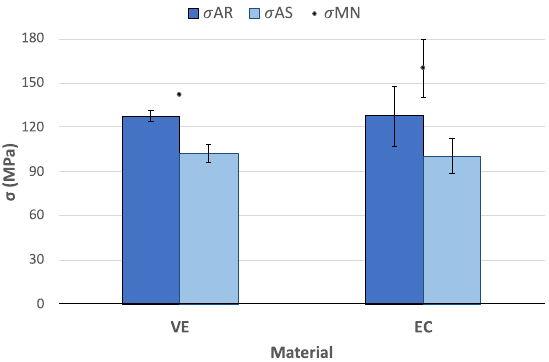
Figure 8. Flexural strength (mean values and their corresponding root mean square errors) after the TPB tests on unnotched samples of the materials AR and after immersion in AS and results from the MN.